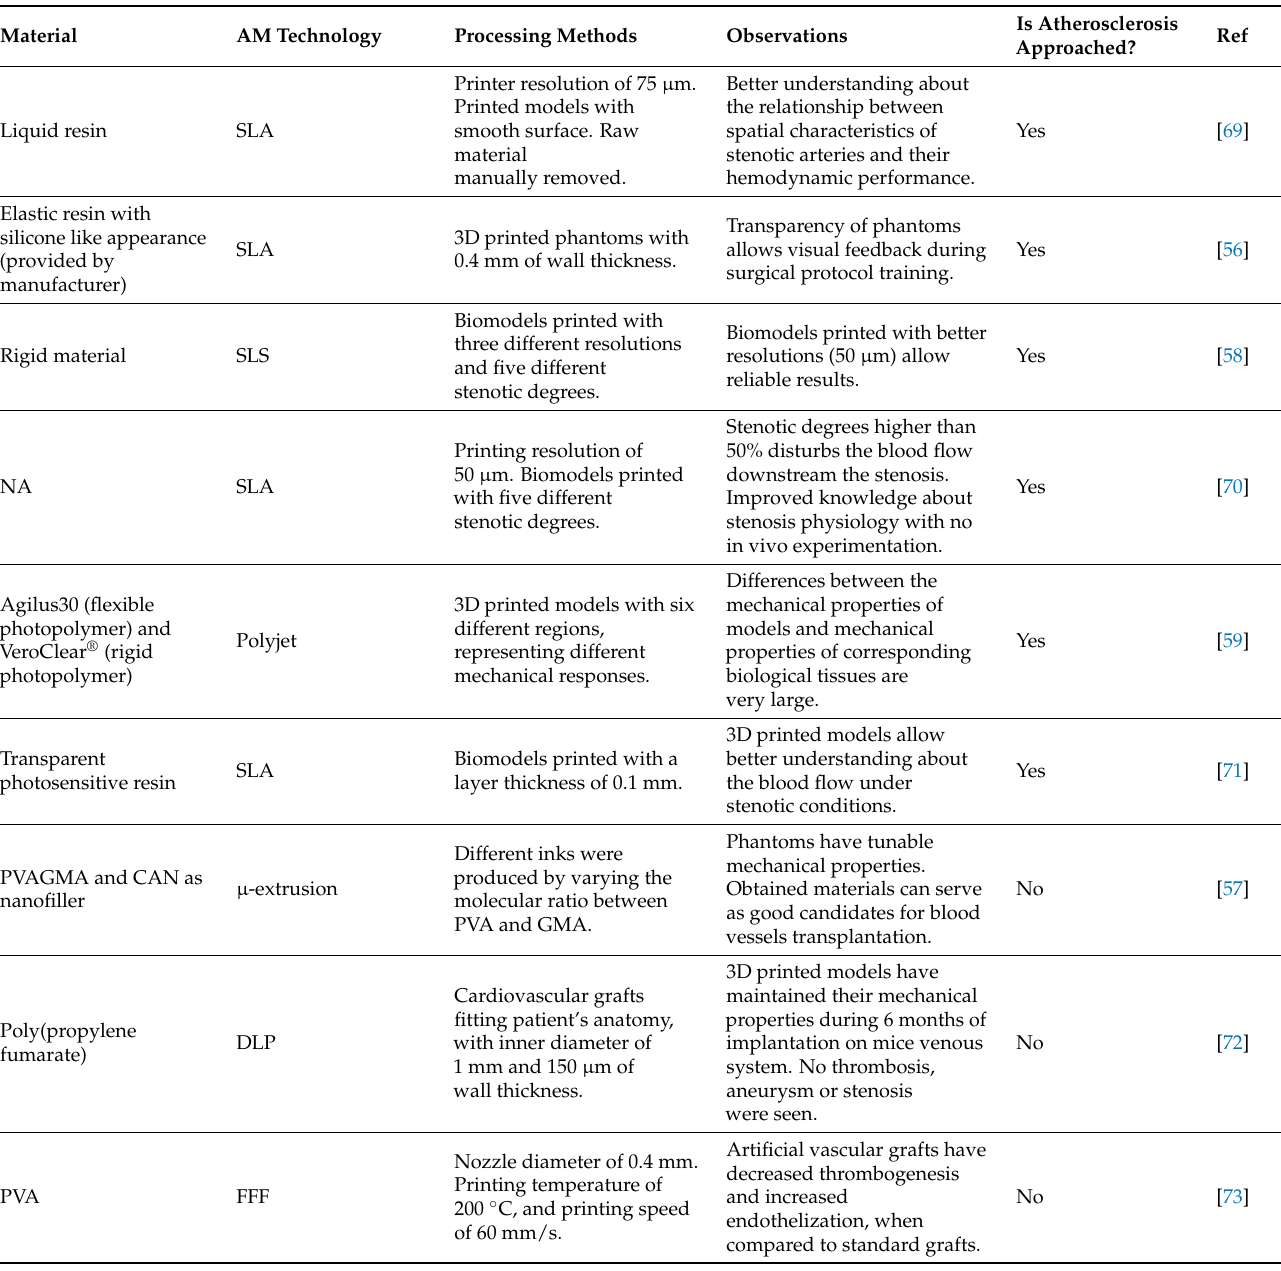
Table 5. Materials used in additive manufacturing to reproduce